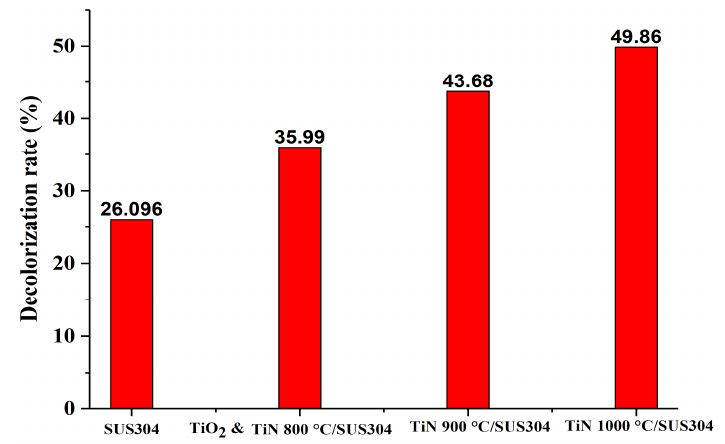
Figure 7. Comparison between the decolorization rates of coated and uncoated SUS304 electrodes in the EF system after 30 min of reaction time. Nanomaterials 2018 , 8 , x FOR PEER REVIEW